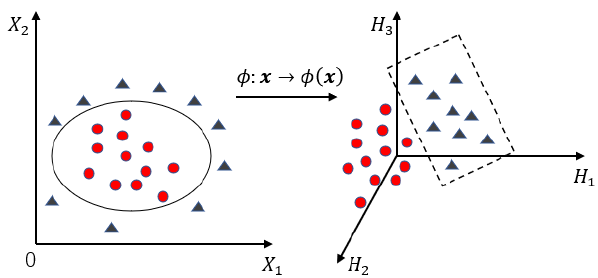
Figure 1. The original data space is mapped to the feature space 𝐻 .